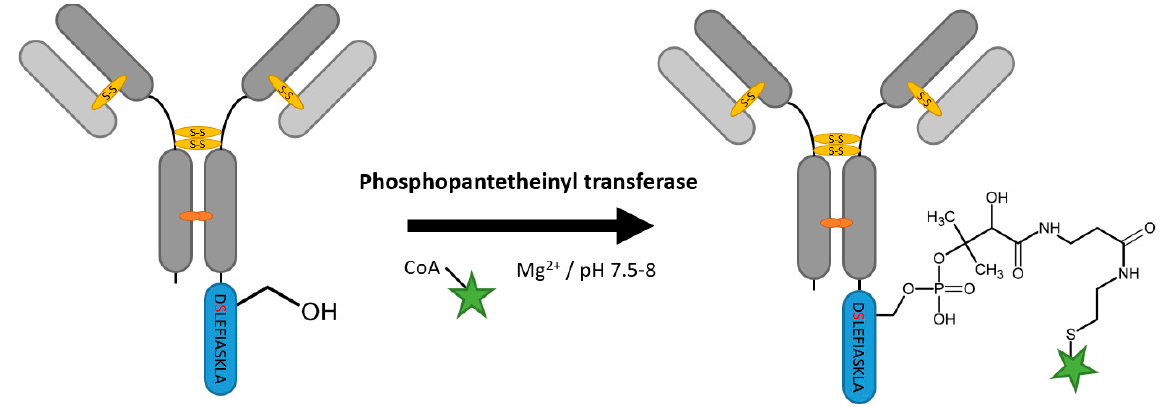
Figure 9. Scheme of an antibody modification by phosphopantetheinyl transferase.